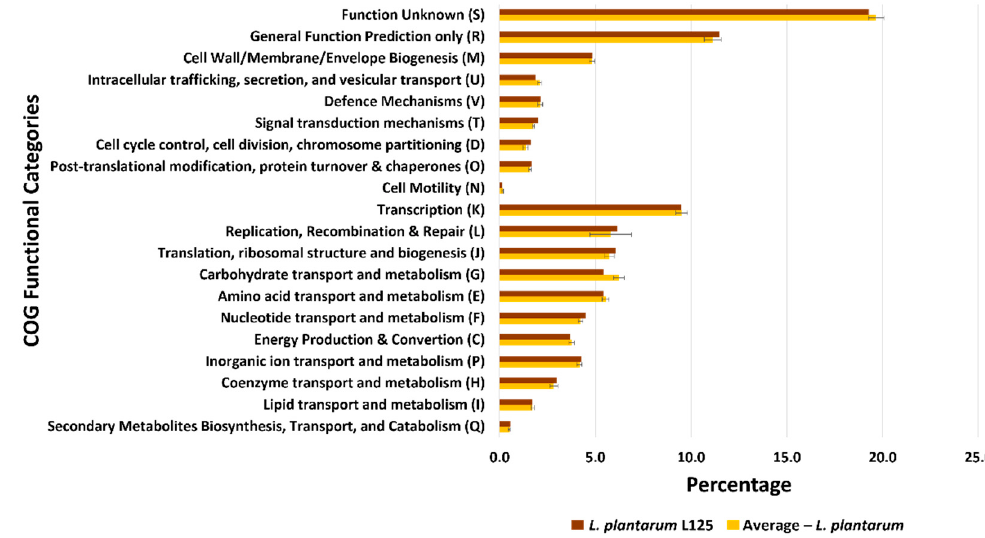
Figure 4. Comparison of the percentage of genes assigned to the COG functional categories of L. plantarum L125 (Brown bars) and of the 21 L. plantarum strains (Yellow bars). For each one of the 21 L. plantarum strains, the percentage of genes for each COG functional category was determined, and average values were calculated (Yellow bars). The values are depicted as mean ± standard deviation.